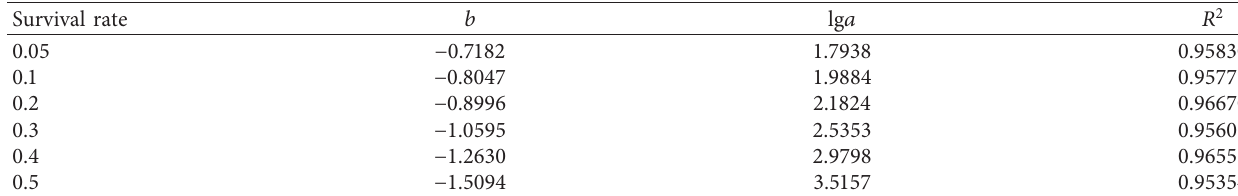
Figure 16: P-S-N curves under different survival rates: (a) p -95%, (b) p -90%, (c) p -80%, (d) p -70%, (e) p -60%, and (f) p -50%. Table 5: CRC creep damage and failure prediction equation